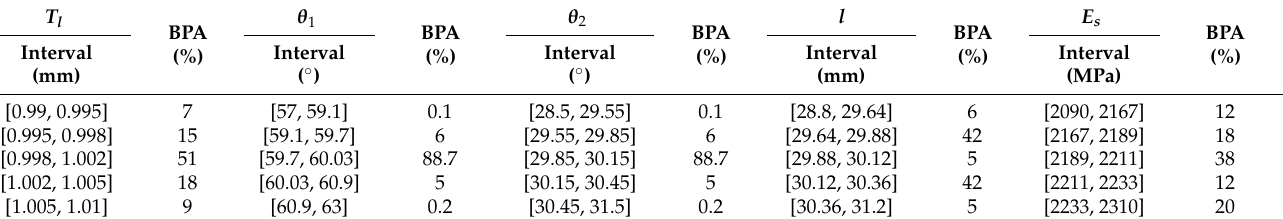
Table 6. The BPAs of an NPR structure with 5 elements.